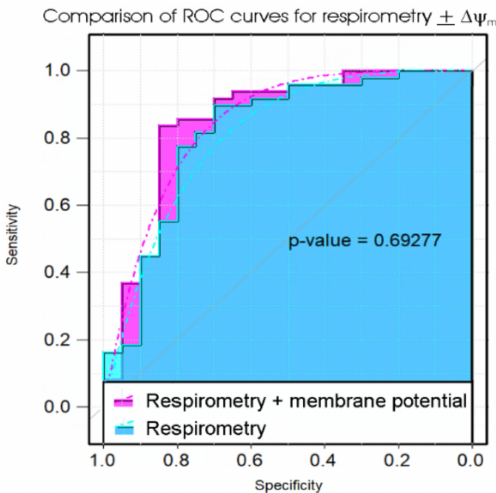
Figure 3. Comparison of ROC curves of propensity scores in logistic regression of five key parameters of lymphoblast respiration with or without measures of the mitochondrial membrane potential. The significance probability of a bootstrap test of the di ff erence between the ROC curves (Robin et al., 2011) is indicated [36]. The addition of the extra laboratory assay (for mitochondrial membrane potential, ∆Ψ m ) did not significantly improve the diagnostic value of the test.